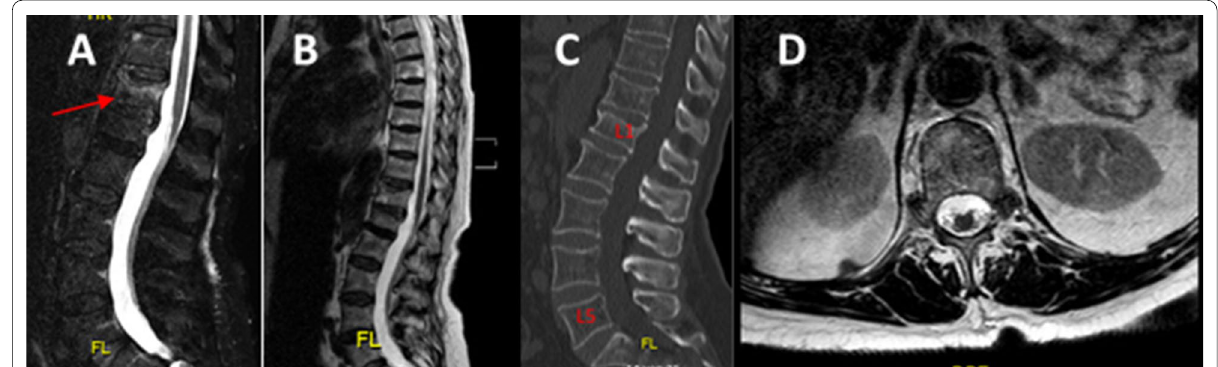
Fig. 1 Indication for surgery. 79 y/o female with osteoporotic L1 vertebral fracture. A MRI STIR sagittal sequence, B T2-sagittal sequence, C CT scan, and D axial sequence of L1 without spinal